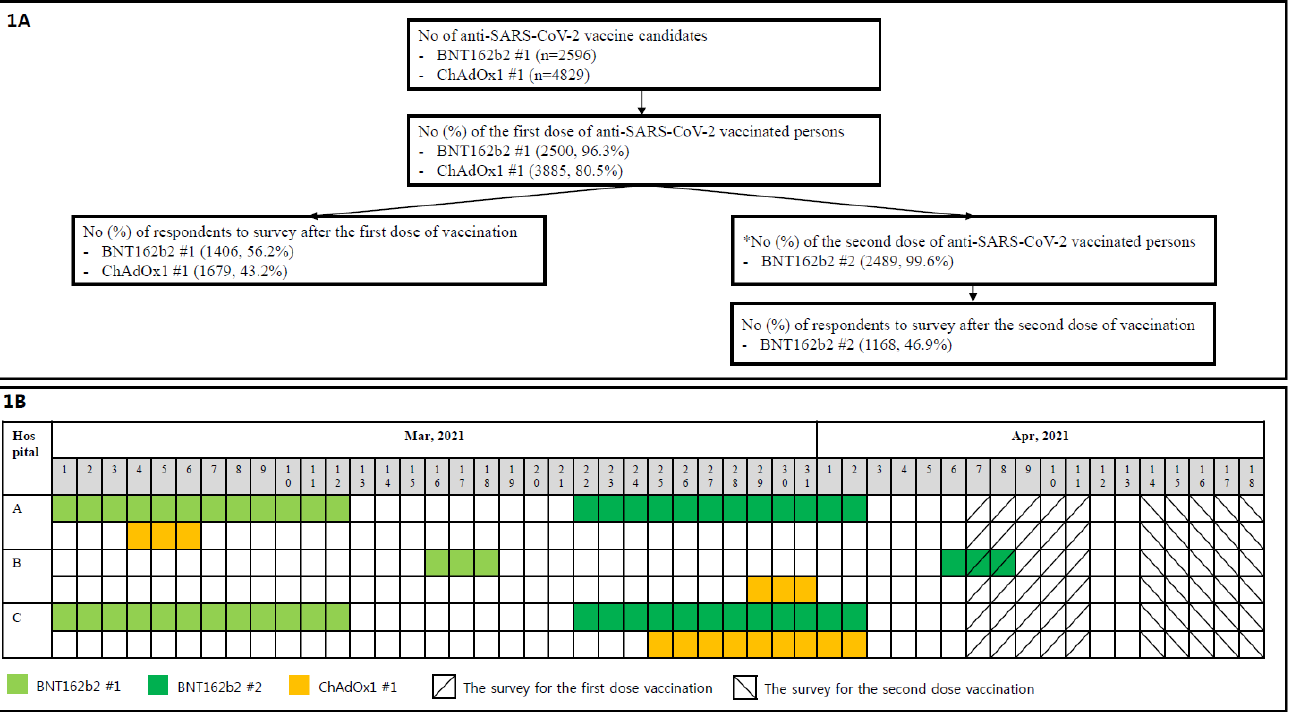
Figure 1. Study design. ( A ) is the study flowchart. ( B ) shows the vaccination and survey timelines. ChAdOx1 #1, the first dose of ChAdOx1; BNT162b2 #1, the first dose of BNT162b2; BNT162b2 #2, the second dose of BNT162b2. * The schedule of the second dose of ChAdOx1 was not reached during the study period.